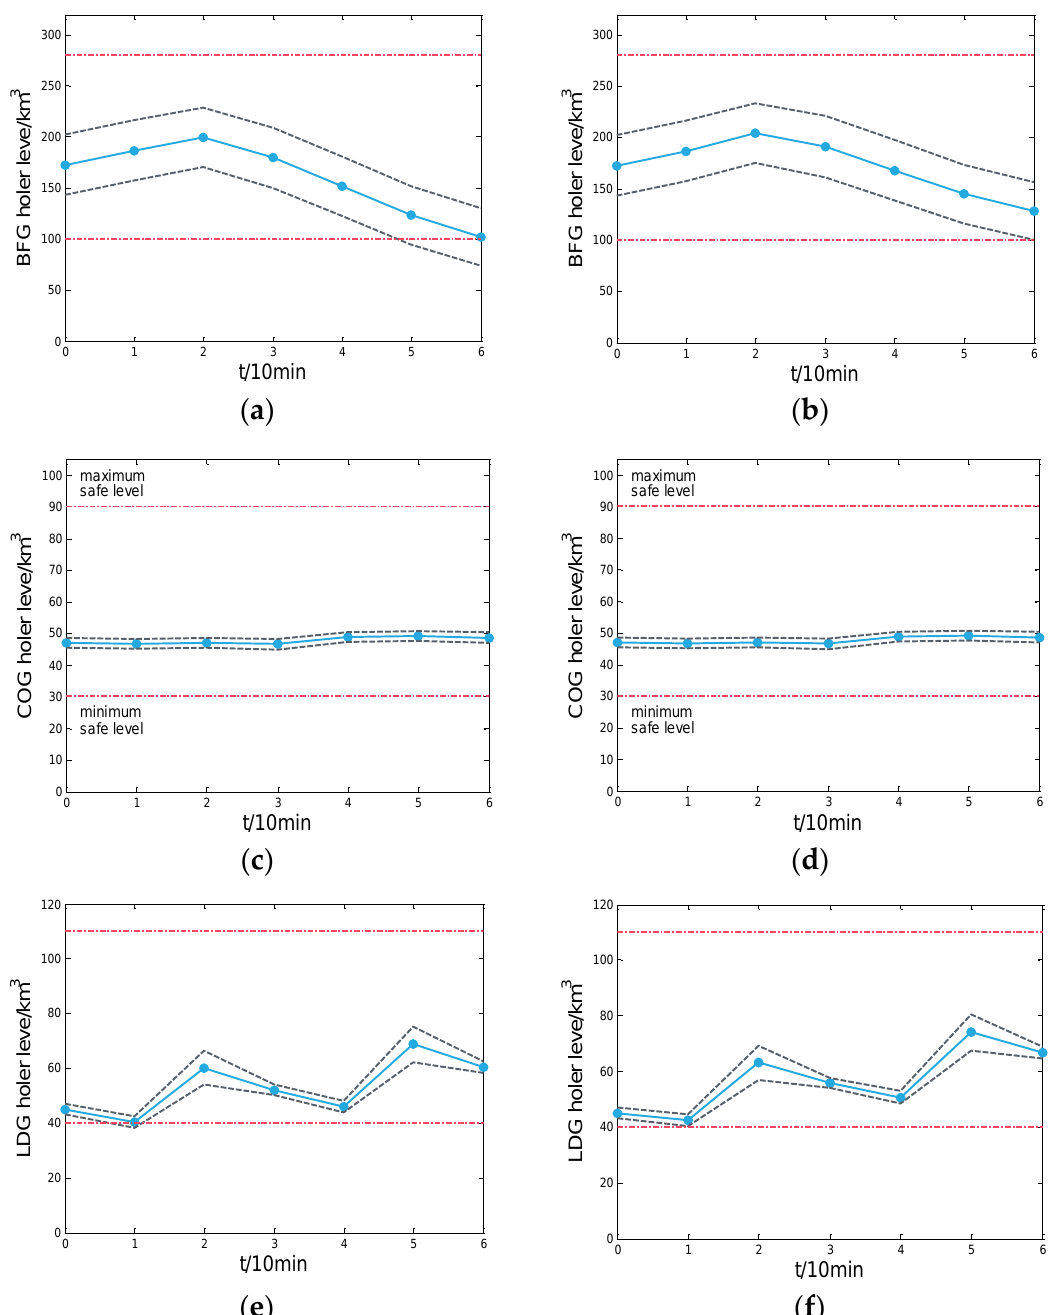
Figure 3. Comparison between deterministic scheduling results and fuzzy scheduling results in gas holder levels of BFG, COG, and LDG. ( a ) BFG holder level by deterministic scheduling; ( b ) BFG holder level by fuzzy scheduling; ( c ) COG by deterministic scheduling; ( d ) COG by fuzzy scheduling; ( e ) LDG by deterministic scheduling; ( f ) LDG by fuzzy scheduling.